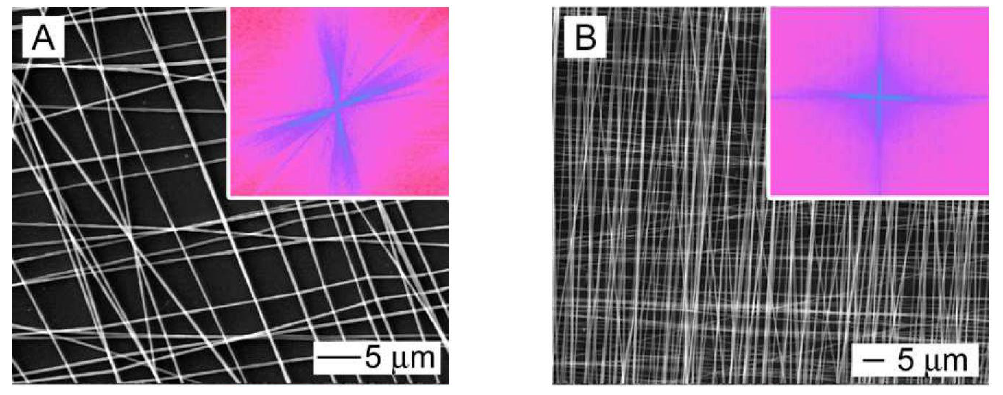
Figure 3. Scanning electron micrographs of double-layered scaffolds with ( A ) low and ( B ) mediate fiber densities, where the fibers were uniaxially aligned in each layer and rotated by about 80° to 90°. The Fourier Fast Transfer (FFT) patterns in the inset of (A) and (B) indicate that the fibers were crossed with an angle of about 80° and 90°, respectively